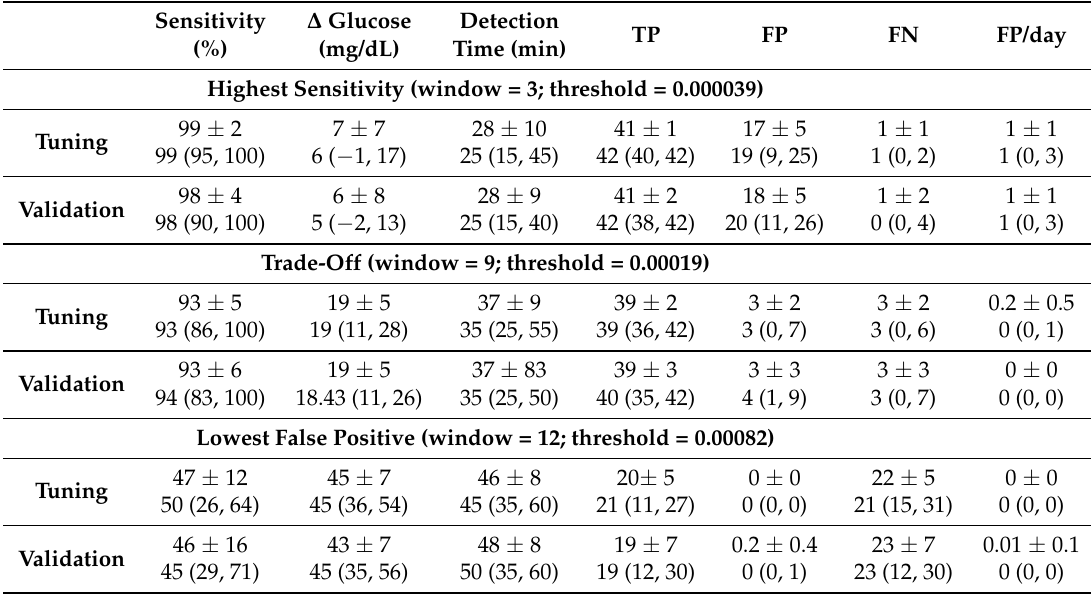
Table 2. Population performance metrics of meal detection algorithm in tuning scenario. Total number of meals per patient was